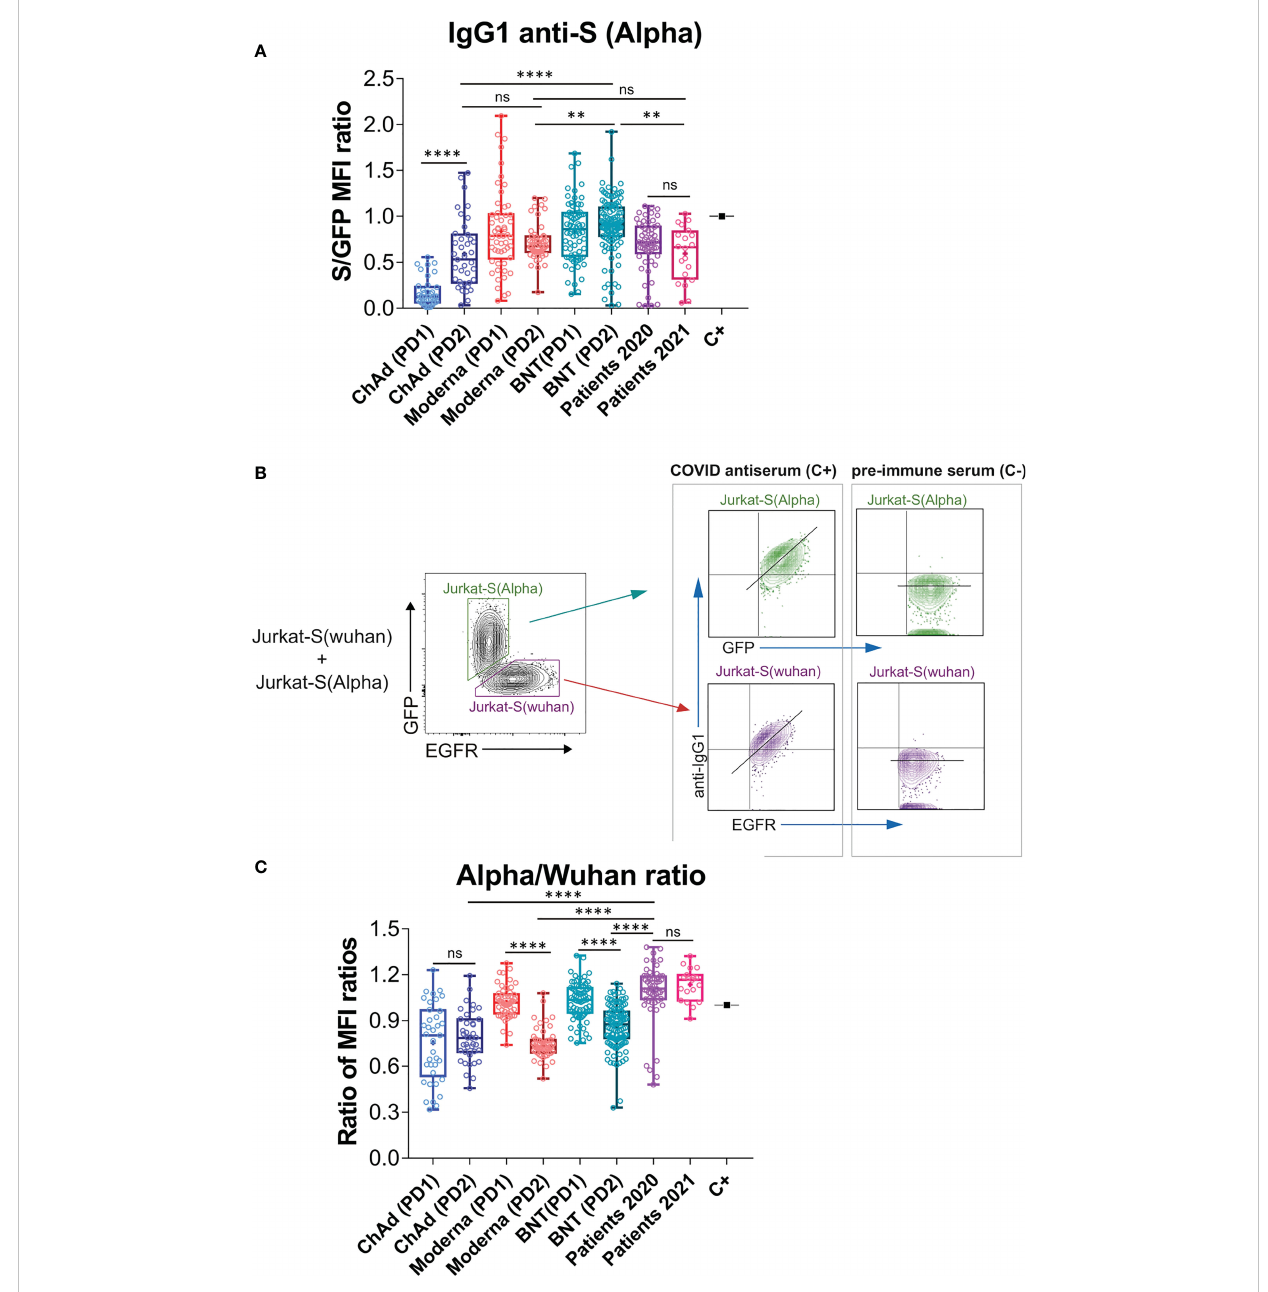
FIGURE 2 Effect of vaccination on the relative recognition of the Alpha and Wuhan variants by sera of vaccinated individuals. (A) Antibody generation against the S protein of the Alpha variant was evaluated 3 weeks after the fi rst dose of BNT vaccine and 4 weeks after the fi rst dose of Moderna, ChAd, and Ad26 vaccines. The evaluation was also done 4 weeks after the second booster dose for all vaccines. The ratio of mean fl uorescence intensities (MFI) of anti-S staining and GFP staining was determined for each serum sample and normalized to the positive control (C+) sample. All sera were used at a 1:50 dilution. Box and whisker plots were used to represent the minimum and maximum values, as well as the median and mean (the mean with a cross). The graph shows the number of samples for each vaccine. The statistical signi fi cance of the results was determined using one- way ANOVA test, with ** indicating p<0.01, **** indicating p<0.0001, and ns indicating not signi fi cant. (B) Gating strategy to measure binding to the Wuhan and Alpha variants. Jurkat-S(Wuhan) and Jurkat-S(Alpha) cells were mixed in 1:1 ratio and incubated with either a 1:50 dilution of a positive control serum (C+) from a patient of the fi rst wave in 2020 or a negative control serum (C-) obtained before the COVID-19 pandemics. Cells were subsequently incubated with mouse anti-human IgG1-PE and mouse anti-human EGFR-BV421 antibodies. After incubation, cells were gated according to lymphocyte FSC-A and SSC-A and subsequently on 7-AAD negative cells (7-AAD+ are dead cells). Live cells were subsequently gated on the FL1 channel (for GFP+ cells) and on the FL7 channel (huEGFRt+ cells). Both GFP+ and huEGFRt+ cells were separately analyzed for the fl uorescence intensity of anti-IgG1 (S protein, FL2) versus GFP (for Jurkat-S(Alpha)) or for the fl uorescence intensity of anti-IgG1 (S protein, FL2) versus EGFR (for Jurkat-S(Wuhan)). A diagonal lane is plotted on the bicolor contour plots corresponding to the C+ staining to indicate a relationship between S protein expression and either GFP or huEGFRt. (C) Relative reactivity of the sera tested in (A) against the Alpha and Wuhan variants measured according to the (S/GFP ratio)/(S/EGFR ratio) and plotted individually for each serum donor. **** p <0.0001; ns, not signi fi cant (one-way ANOVA